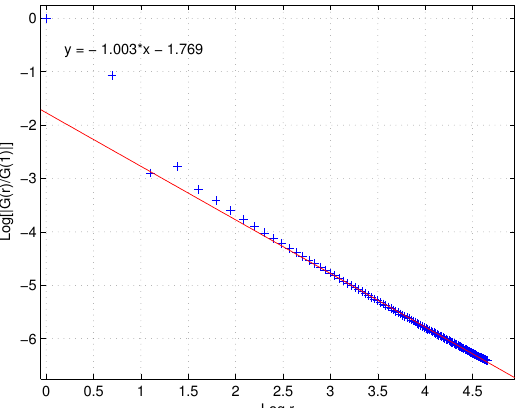
Figure 5: Log-plot of the Green’s function | G ( r ) / G ( 1 ) | along a chain direction in the complex parton state of Fig. 4. The spectrum with Fermi lines is shown there. The system is periodic with linear size L = 512. Correlations up to r = 105 are shown. The 1 / r -decay implies an algebraic spin-spin correlation 1 / r 2